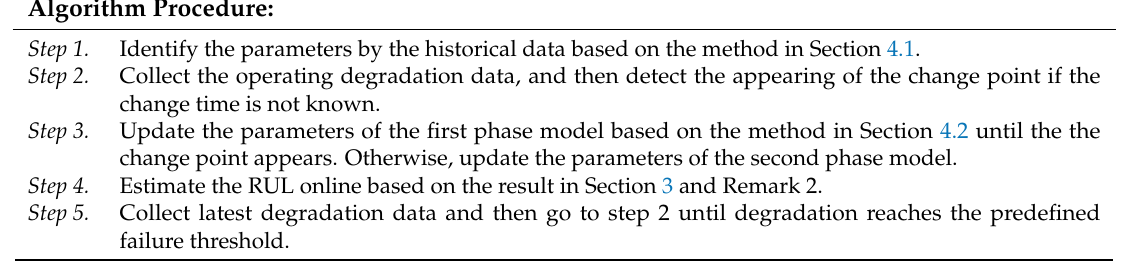
Table 2. The implementation procedures of RUL estimation for the degradation device.